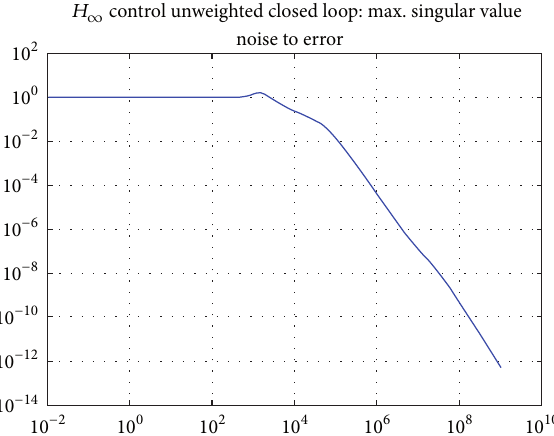
Figure 11: Maximum singular value of the unweighted closed loop system.